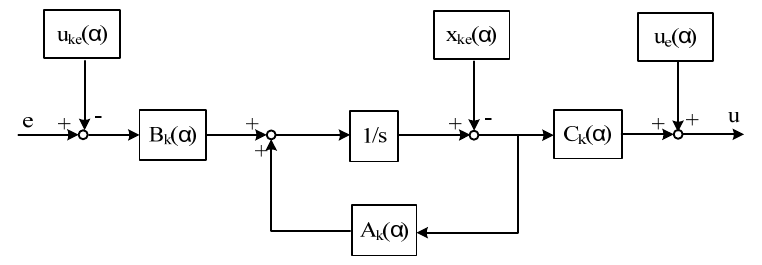
Figure 12. Modified H ∞ LPV controller.